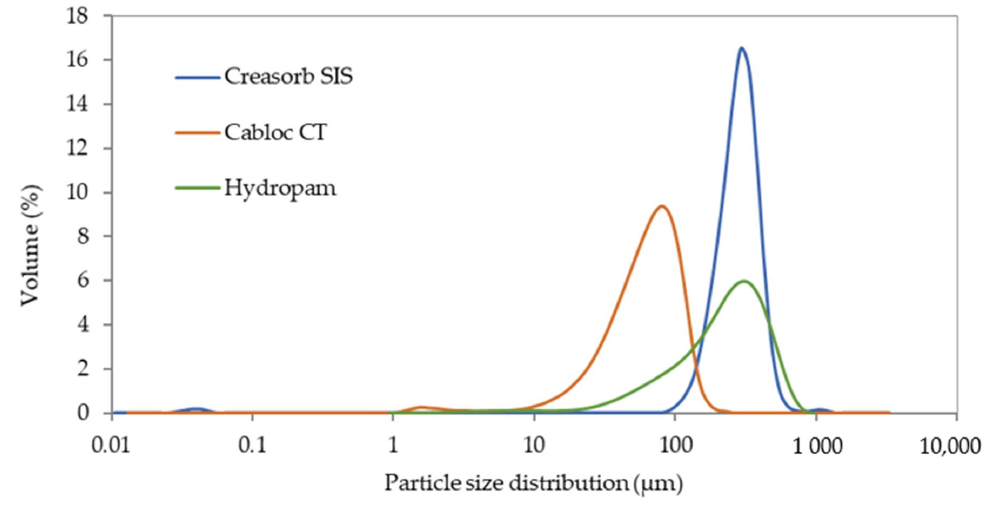
Figure 1. Particle size distribution of studied SAPs.